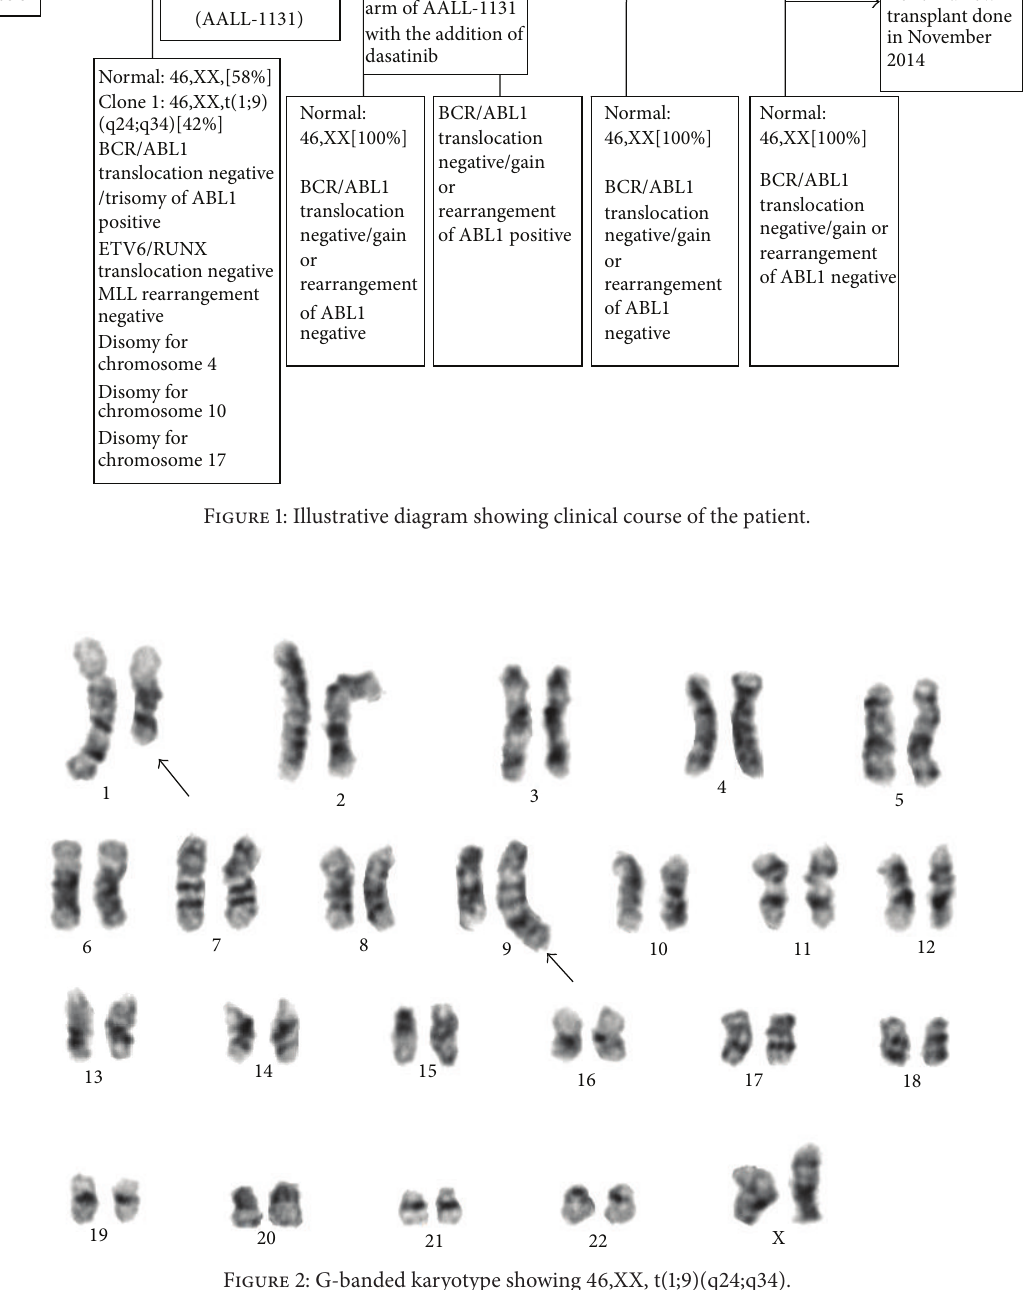
Figure 2: G-banded karyotype showing 46,XX,